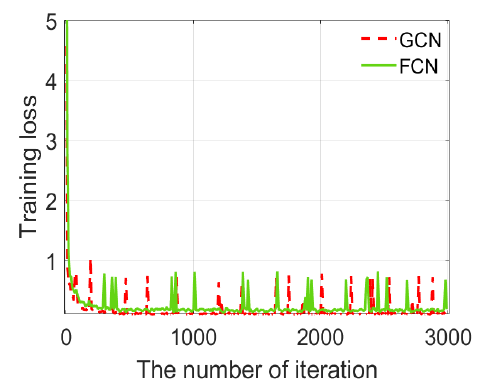
Figure 6. Training loss in the training